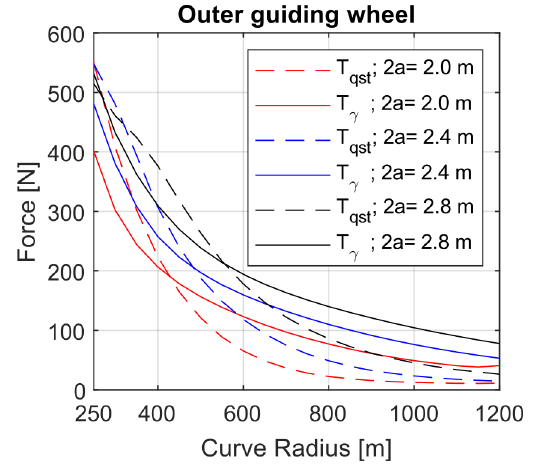
Figure 10. Dependence of the T curve radius R for defined values of the bogie wheel- base 2 a